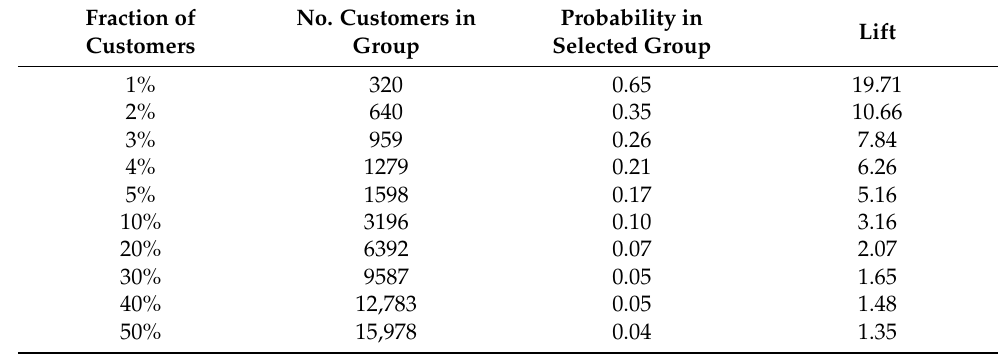
Table A2. Lift values for selected quantiles—general probability of buying for second time is